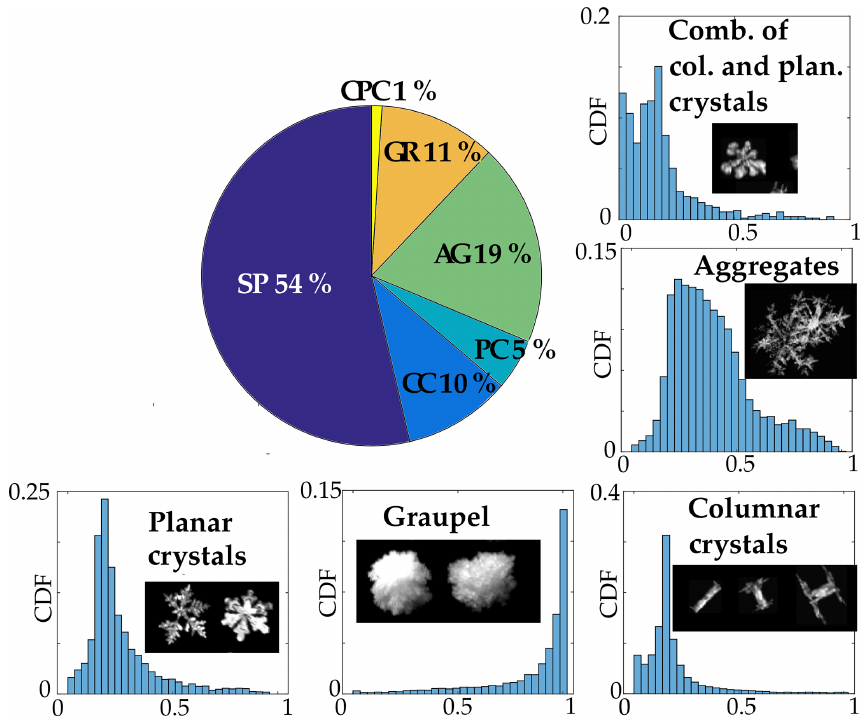
Figure 8. Pie chart of the hydrometeor types classified by the MASC instrument in the period from the 21 November 2015 to the end of January 2016. The histograms shows the distribution of a riming index, ranging from 0 (unrimed) to 1 (fully rimed), for the particles of each hydrometeor class. The riming index is undefined for small particles, i.e., particles that are too small to be identified as a particular hydrometeor class. The classes of the chart are small particles (SP), columnar crystals (CC), aggregates (AG), planar crystals (PC), graupel (GR), combination of columnar and planar crystals (CPC), as described in Praz et al.